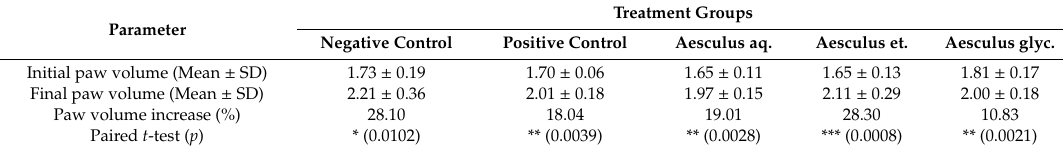
Table 2. Hind paw volume (cm 3 ) of rats receiving intraplantar carrageenan and topical gels. Treatment Groups Parameter Negative Control Positive Control